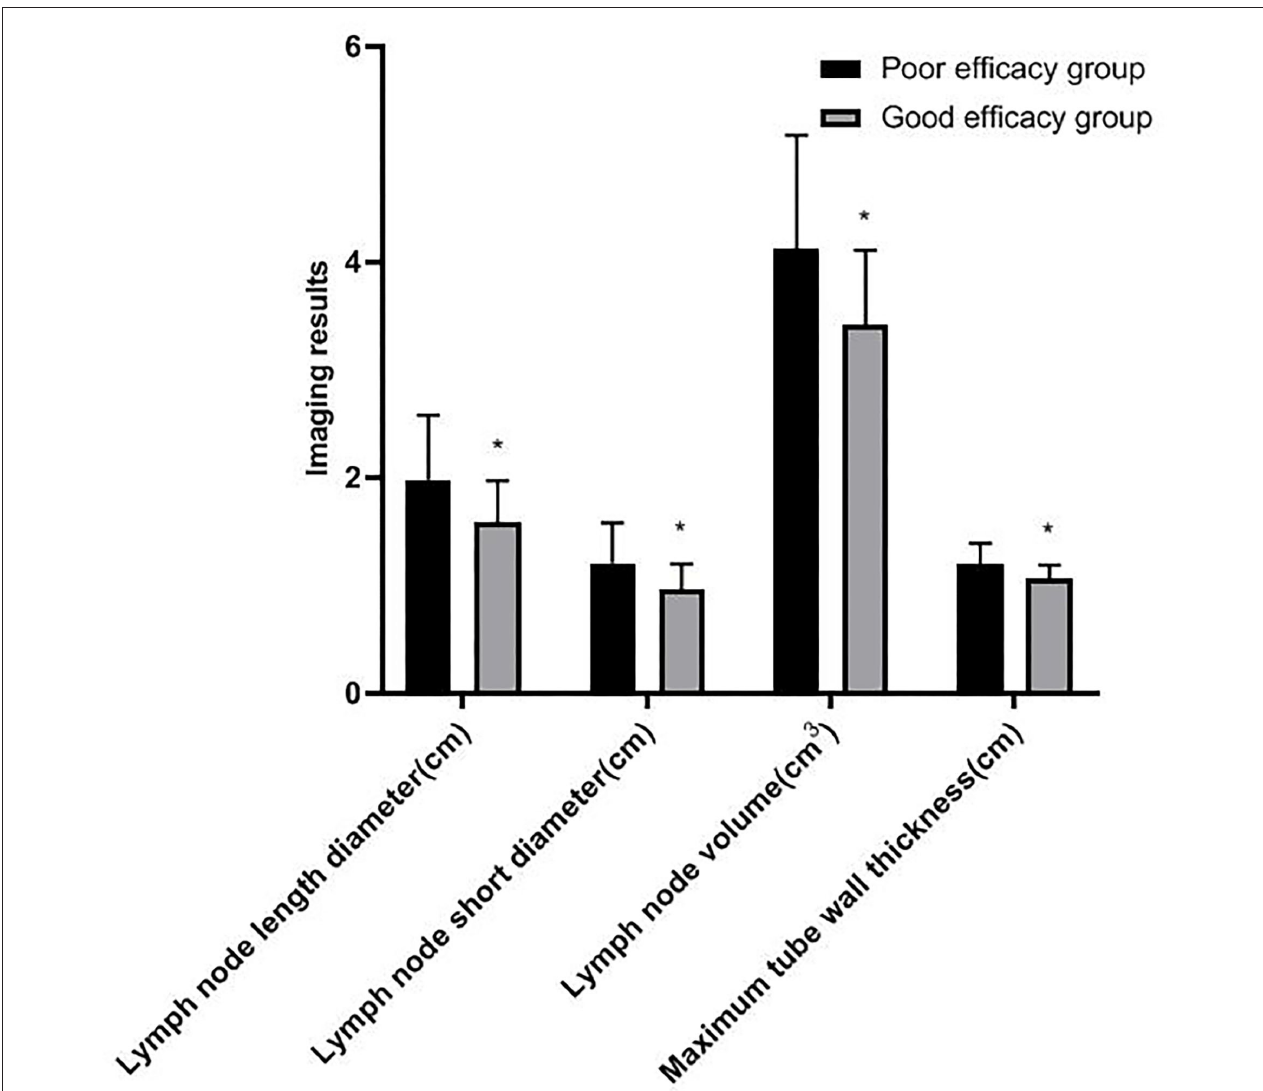
FIGURE 2 | Comparison of imaging results of patients with different efficacy. Compared with the poor efficacy group, * p <